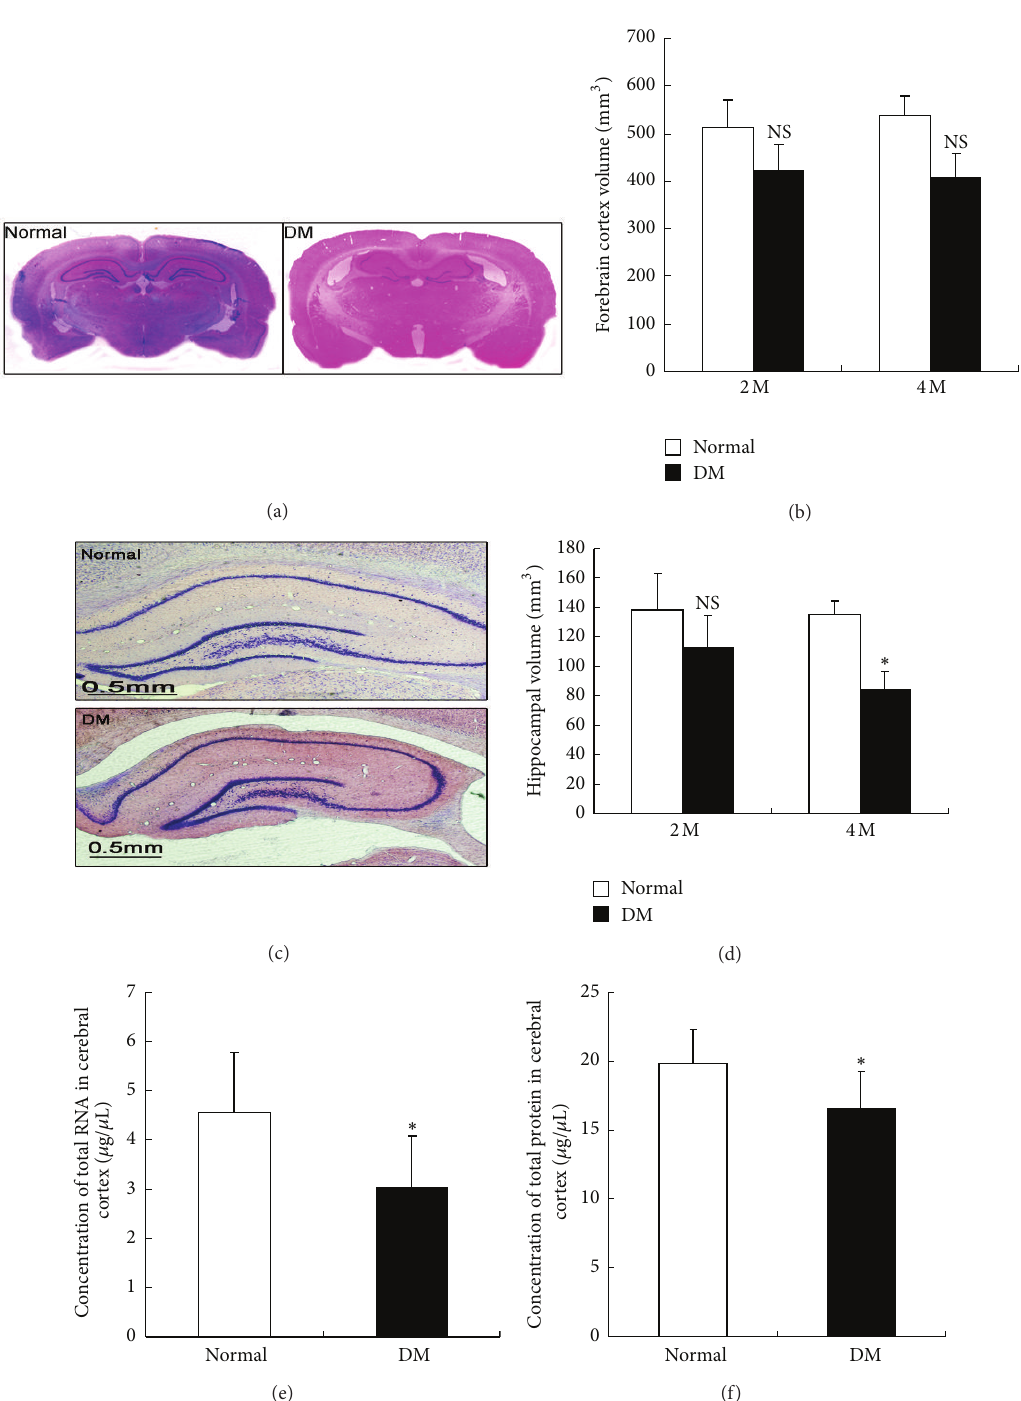
Figure 2: Changes in the brain sterostructure of STZ-induced diabetic rats. (a) Representative forebrain images at 4 months after STZ injection. (b) Forebrain volume measurement (see Materials and Methods for procedure details). (c) Representative images of rat hippocampus at 4 months after STZ injection. (d) Hippocampal volume measurement (see Materials and Methods for procedure details). ∗ 𝑃 < 0.05 , significant difference compared with the age-matched control rats; 𝑛 = 6 . ((e) and (f)) Total RNA and protein concentrations were measured in whole brain at 4 months after STZ injection. ∗ 𝑃 < 0.05 , significant difference compared with the age-matched control group; 𝑛 = 4